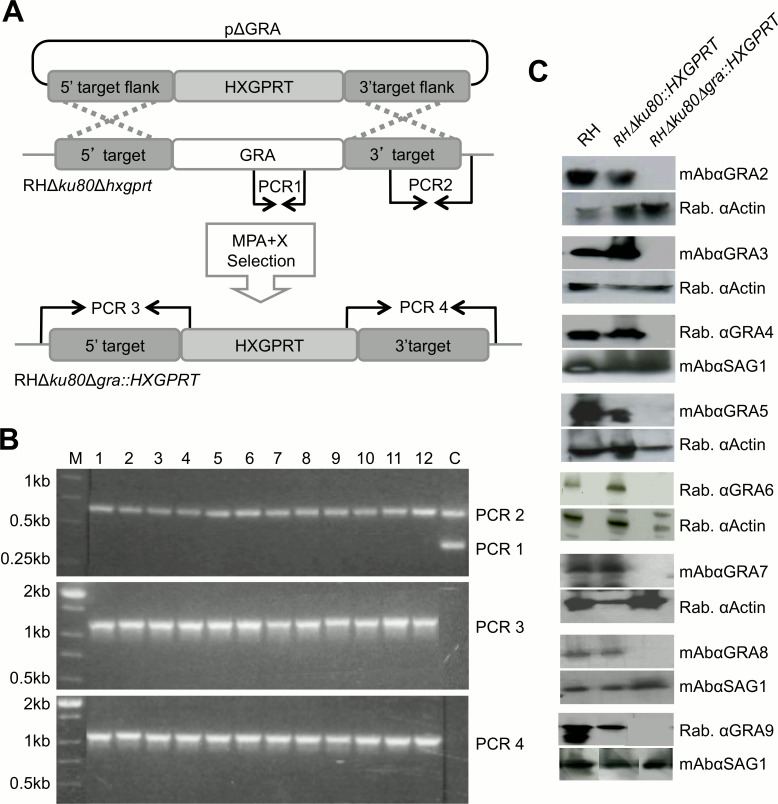
Construction and validation of the single GRA2-9 knockout strains.A) Strategy for disruption of a GRA gene locus by double crossover homologous recombination in type I RHΔku80Δhxgprt using a plasmid, pΔGRA, engineered to contain the 5’ and 3’ target flanks surrounding the HXGPRT selectable marker. Successful recombination events were selected by mycophenolic acid plus xanthine (MPA+X). This strategy is representative of each of the gene knockout attempts. B) Validation of the Δgra4 targeted gene deletion by PCR. The control parental strain is positive for PCR 1 (~ 380 bp) and PCR 2 (~ 670 bp) but negative for PCR 3 (~ 1,100 bp) and PCR4 (~ 1,200 bp). Clones 1–12 exhibit the banding pattern of a targeted Δgra4 gene knockout,. M: DNA size ladder. C) Western blot validation of the deletion of GRA2-9. Cell lysates from the equivalent of 2 x 107 parasites were loaded per lane, separated on a 13% SDS-PAGE (non-reduced conditions), probed with primary antibodies (indicated on the side of the gels), then with goat anti-mouse IgG or goat anti-rabbit IgG, both coupled to peroxidase and visualized by chemiluminescence.